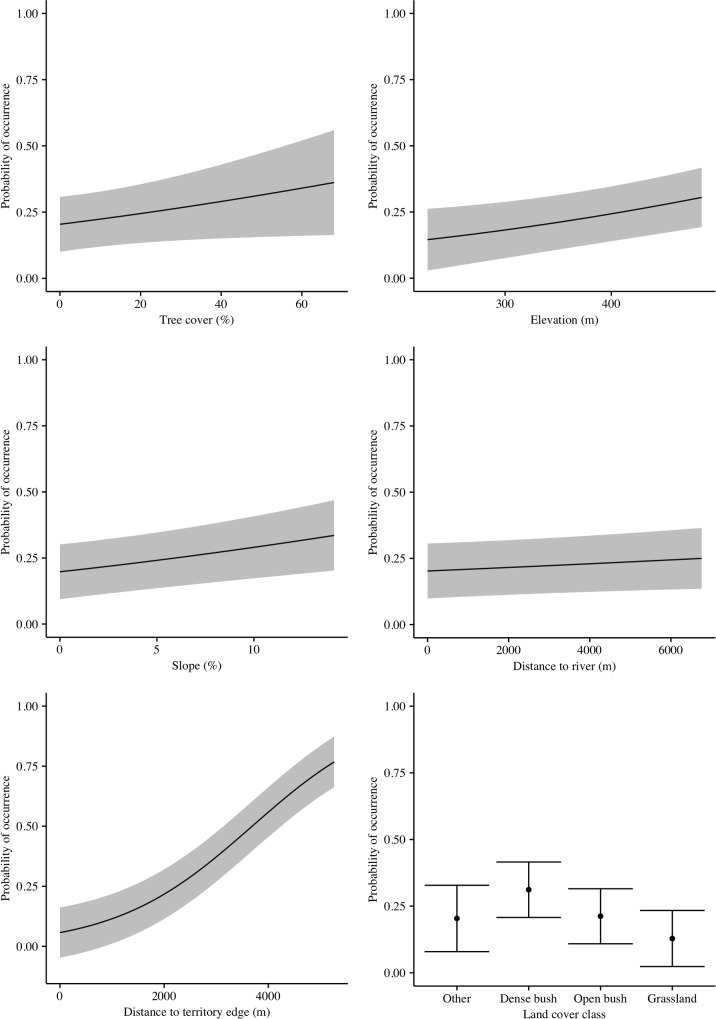
Generalized linear mixed model (GLMM) predictive fixed-effects plots showing the modelled habitat utilization of territorial Martial Eagles tracked after their capture in KNP according to several habitat features: tree cover, elevation, topographic slope, distance to nearest river, distance to nearest road, and land cover.Solid lines show the predicted relationships, with 95% CL captured within grey shaded areas. The bottom right panel shows the predicted probability for the categorical factor, land cover, with 95% confidence limits represented by vertical lines.